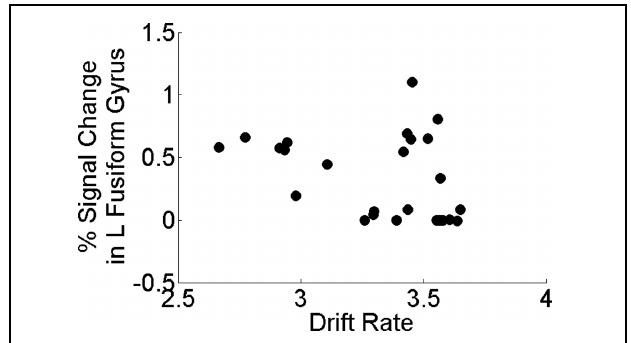
FIGURE 5 | Correlation between drift rate ( v c ) and brain activation in left fusiform gyrus within the MDD group only. Perceptual processing efficiency was negatively associated with task activation in left fusiform gyrus ( r s = − 0.441, p = 0.021) in the MDD group only. All correlations were two-tailed tests using the non-parametric Spearman’s rank correlation